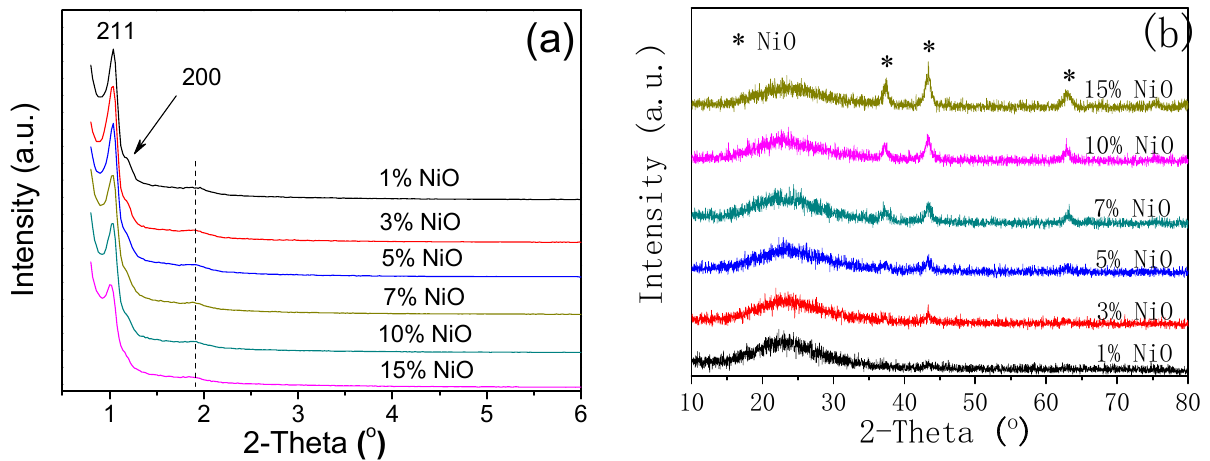
Figure 2. ( a ) Low-angle XRD patterns and ( b ) Wide-angle XRD patterns of NiO/KIT-6 catalysts with various NiO loading amounts (*NiO: NiO diffraction peak).